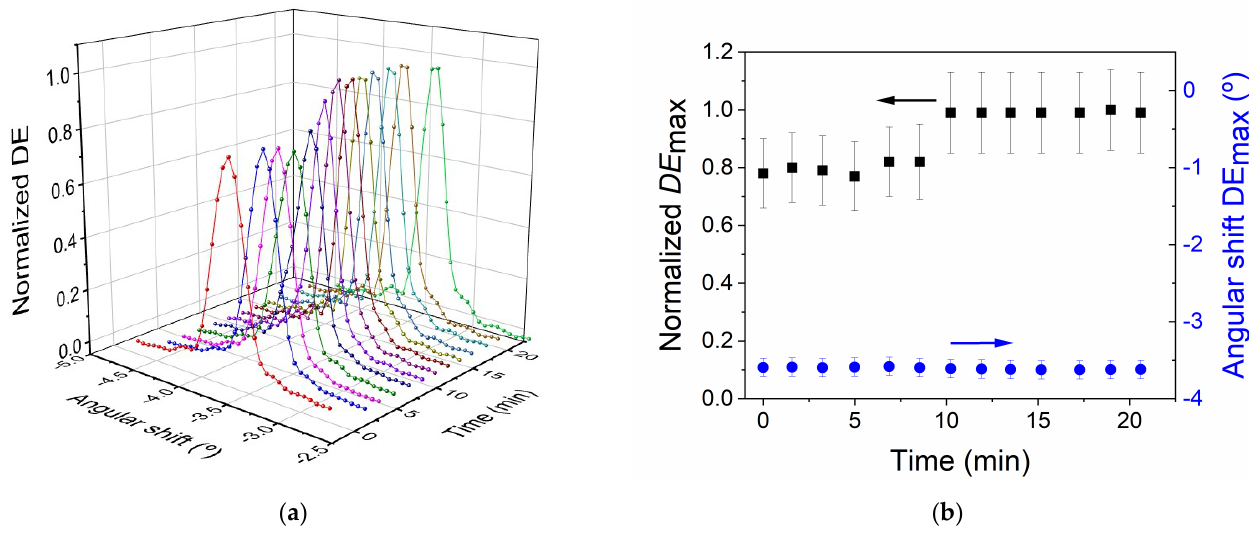
Figure 8. ( a ) Temporal evolution of the normalized DE and angular shift for holograms stored in hydrogel matrices out of the solvent during the reconstruction step. ( b ) Maximum values of the Normalized DE max (black square) and angular shift of the DE max (blue circle) as a function of time.